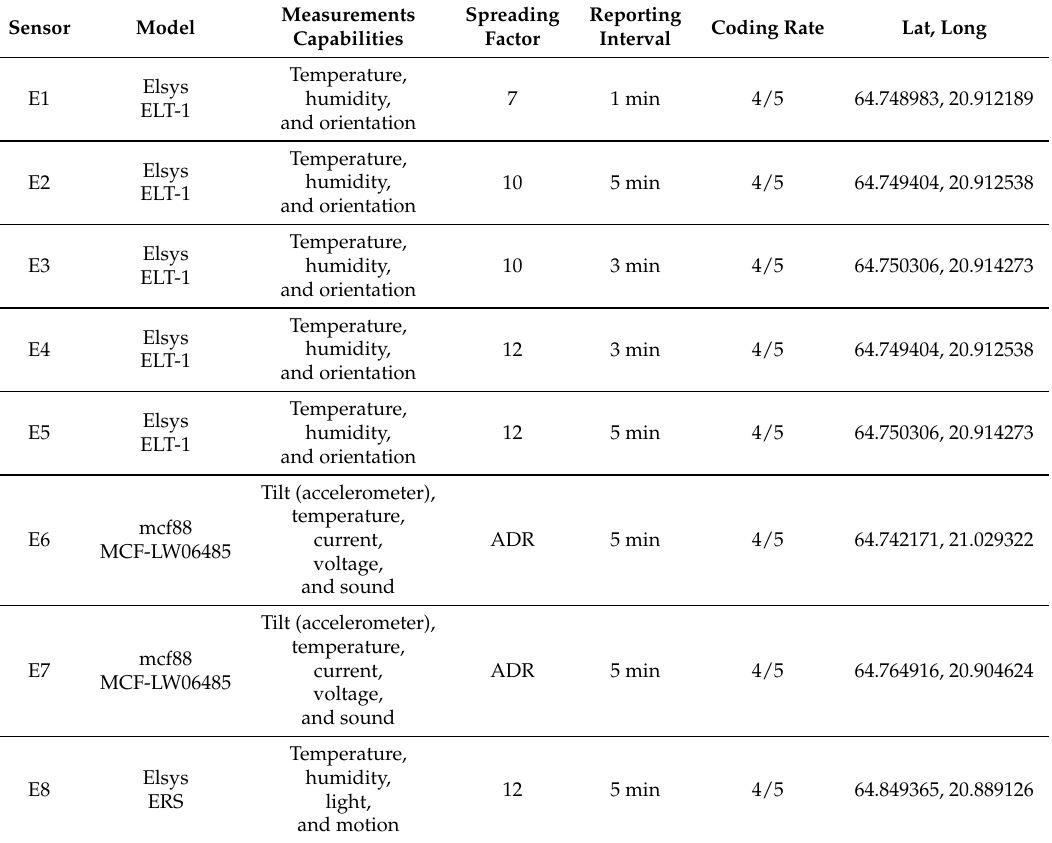
Table 3. Sensors Configuration and